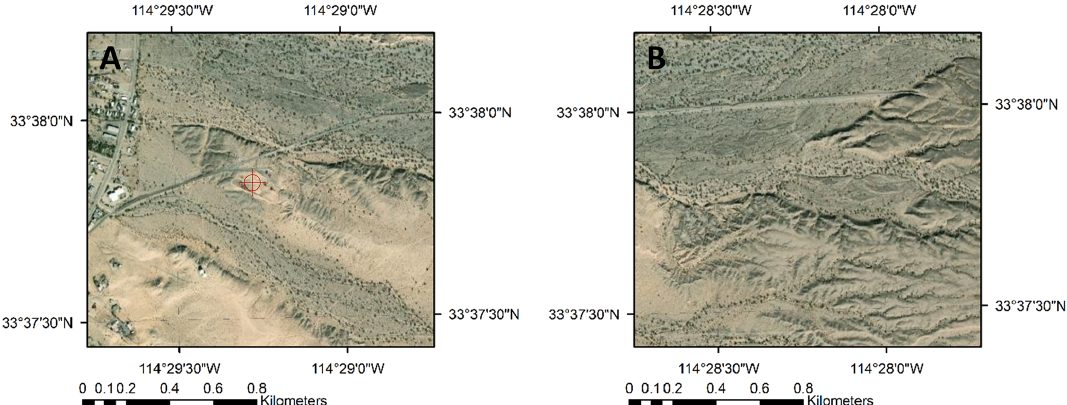
Figure 4. Study regions. Region A covers the controlled-release point source (red-marked, 33.6306 ◦ N, 114.4878 ◦ W) and is mainly used for the controlled-release calibration. Region B is to the east of region A with the same area and is used for the application study. The basemap is the ArcGIS Online World Imagery Basemap. The sources for the data used are as follows: Esri, DigitalGlobe, GeoEye, i-cubed, USDA FSA, USGS, AEX, Getmapping, Aerogrid, IGN, IGP, swisstopo, and the GIS User